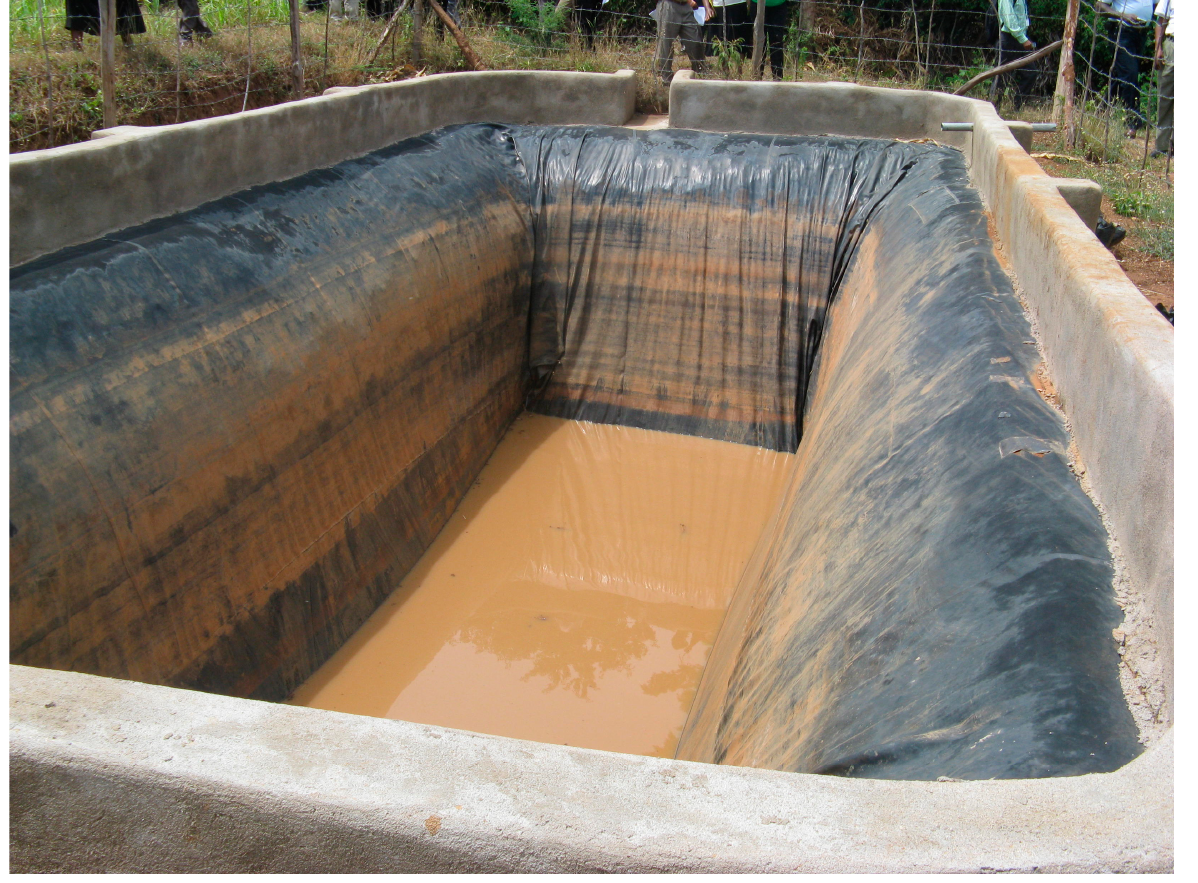
Figure 13. Plastic-lined pond for rainwater collection used in harvesting surface runoff for irrigation in Tanzania. Ponds should be covered to (i) minimize evaporation loss, (ii) protect harvested water from vagabonding animals, and (iii) avoid drowning of children. Own archive photograph, taken in Kilimanjaro region. Table 2. Benefits of the application of the Kilimanjaro Concept (KC) in